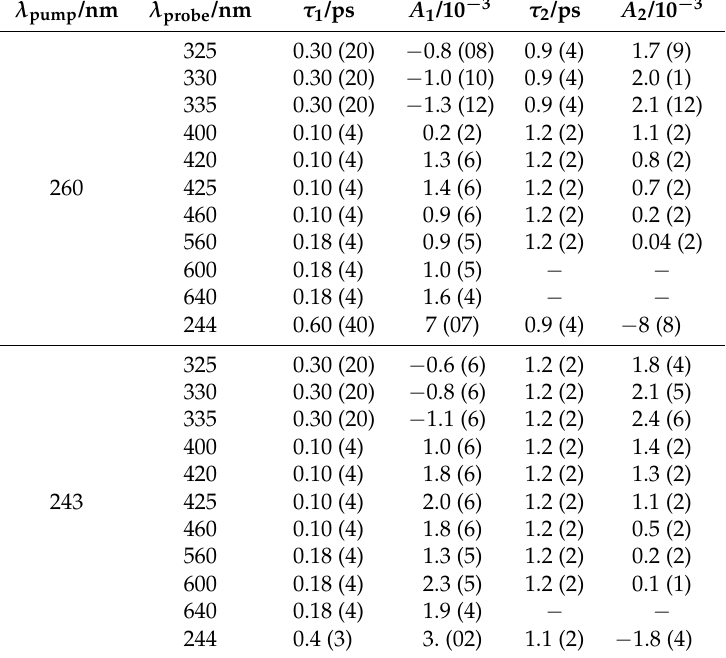
Table A2. Decay times τ i and associated amplitudes A i from the preliminary simultaneous analysis at selected probe wavelengths of the observed changes in optical density in the transient absorption measurements for XMP after excitation at λ pump = 260 and 243 nm (2 σ error limits of last digits in